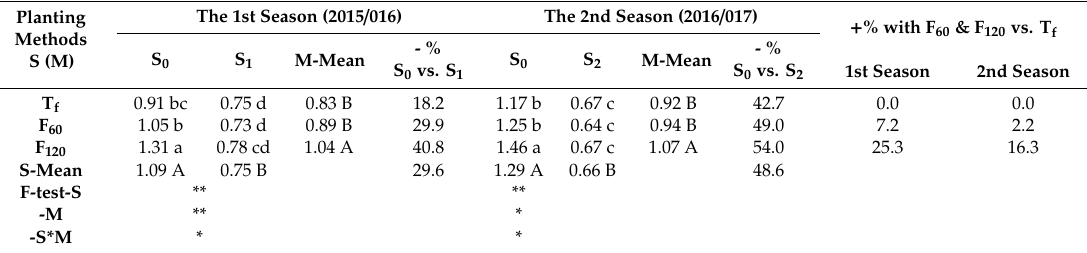
Table A3. P IW (kg m − 3 ) under di ff erent planting methods (M) and salinity conditions (S). Planting